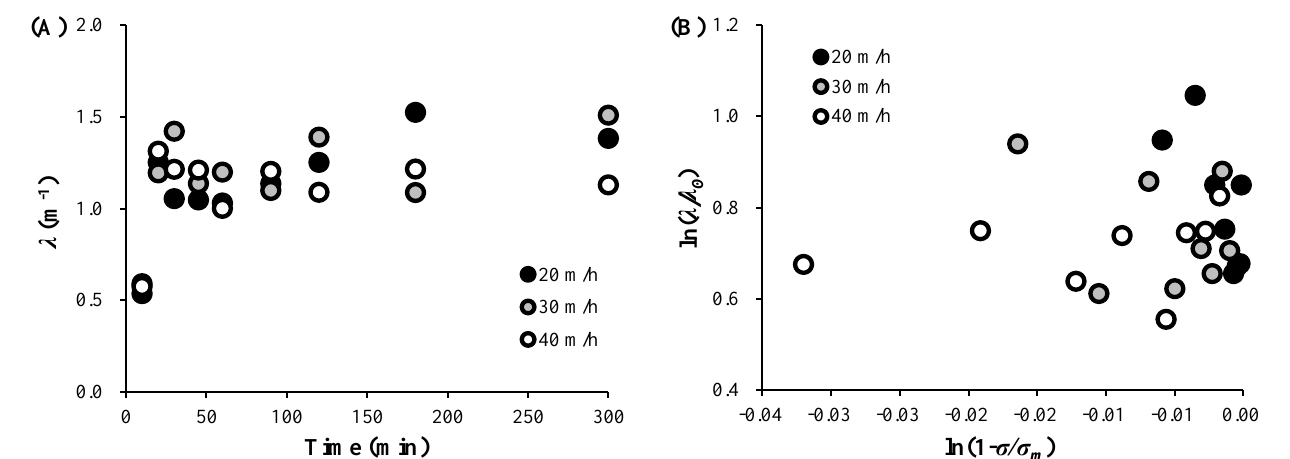
Figure 4. The deep bed filtration model: ( A ) the time evolution of λ ; ( B ) the correlations between λ and σ .